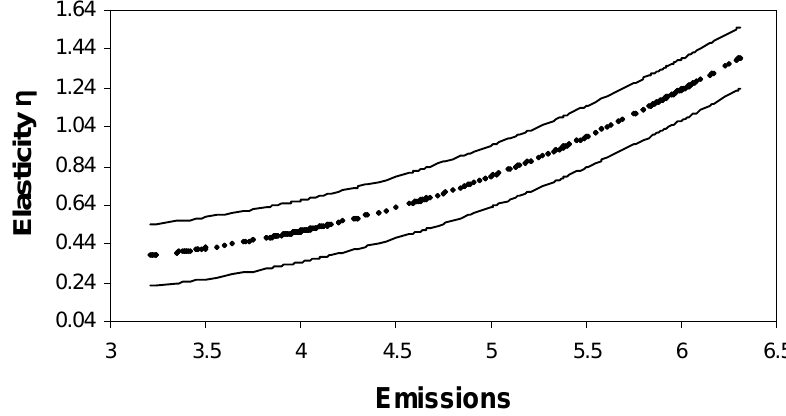
Figure 2. Elasticity of Figure 2: Elasticity of Emissions